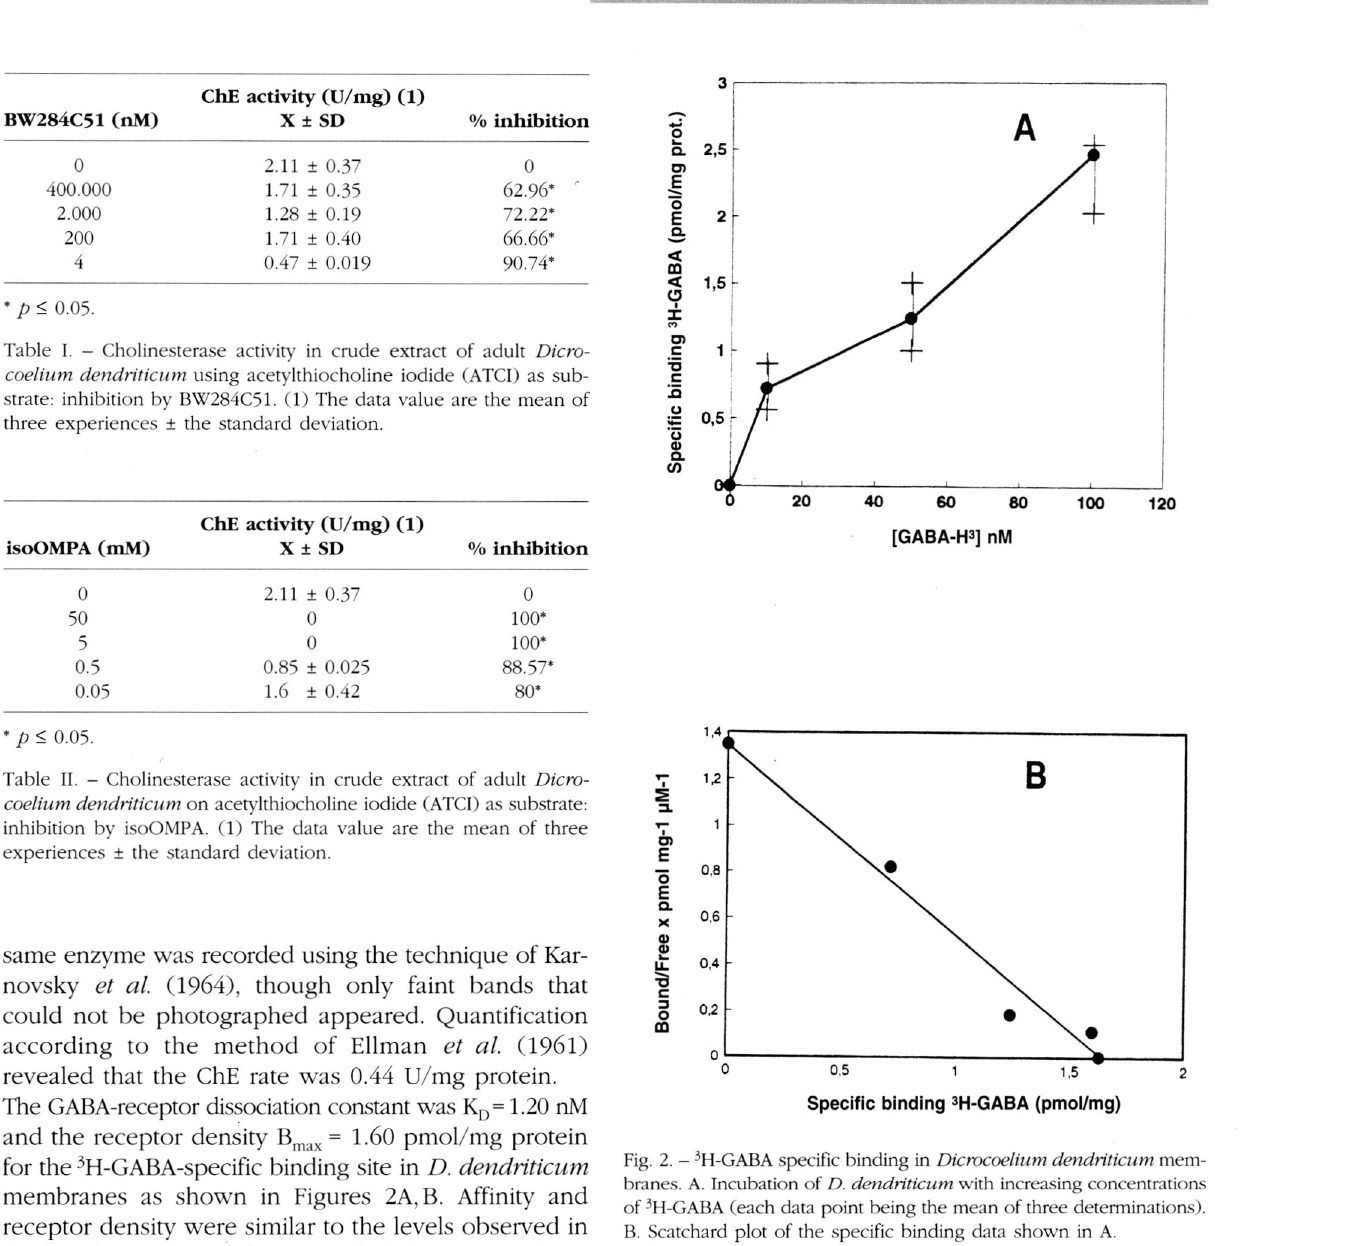
ChE activity (U/mg) (1)